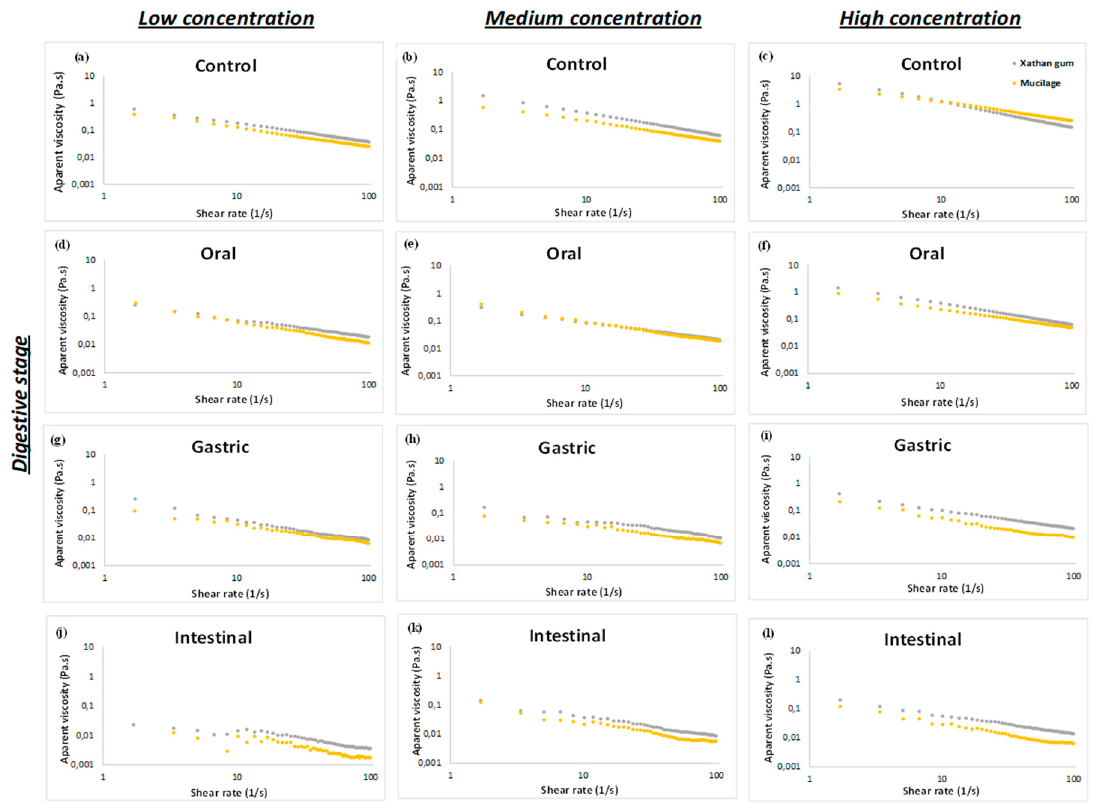
Figure 1. Apparent viscosity during in vitro